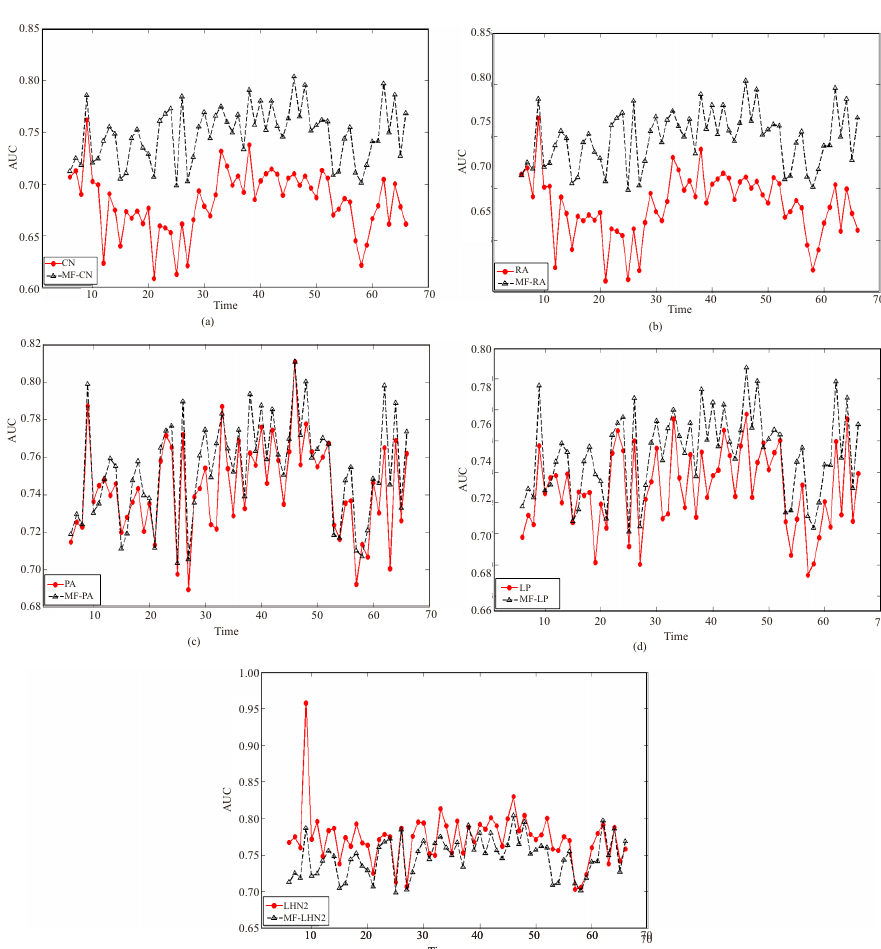
Fig. 5 Performance of different methods on News